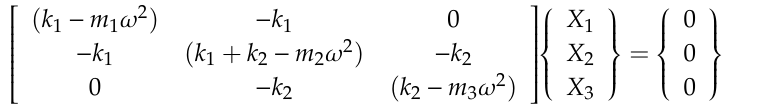
Figure 11. Estimation results of F-V model for MR damper : ( a ) Comparison results between